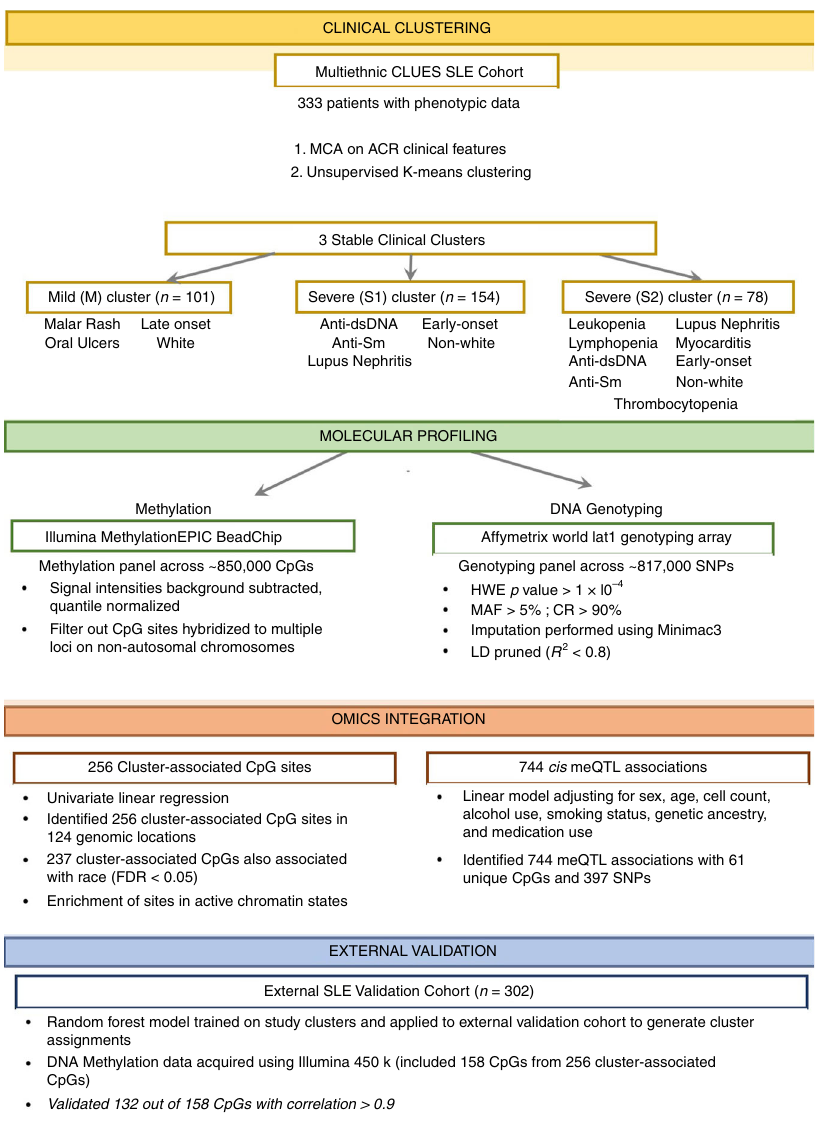
Fig. 1 Integrative analysis pipeline. An overview of the omics data integration strategy used to characterize clinical clusters identi fi ed by K-means clustering. MCA = Multiple Component Analysis, HWE = Hardy-Weinberg Equilibrium, MAF = minor allele frequency, LD = linkage disequilibrium, FDR = false discovery rate, meQTL = cis-methylation quantitative